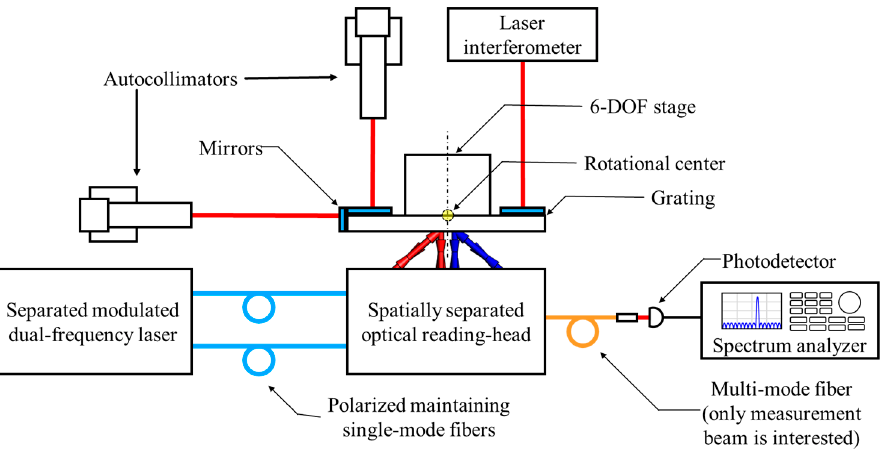
Figure 9. Experimental setup for testing the performance of alignment tolerance.